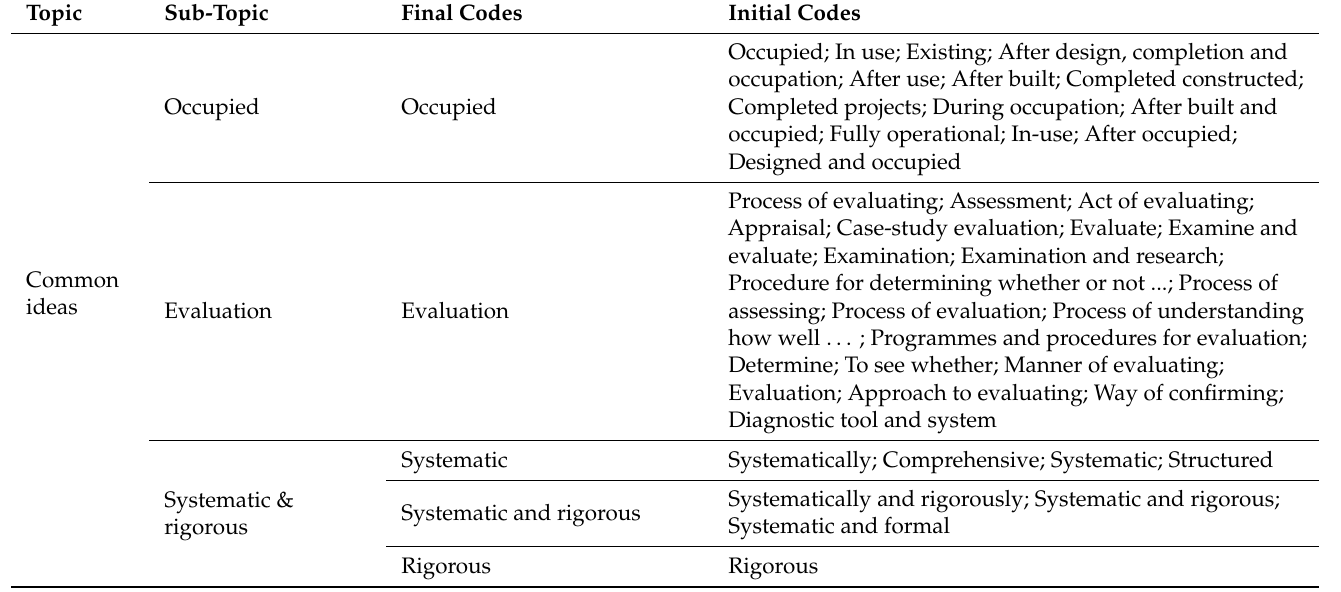
Table A3. Procedure of Axial Coding of POE